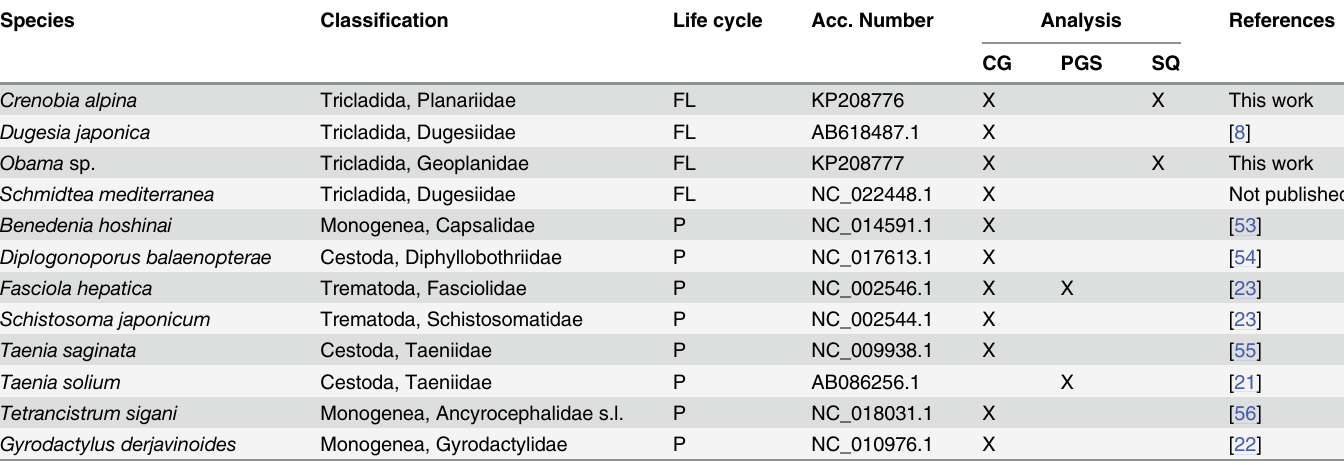
Table 1. List of all Platyhelminthes species included in the present